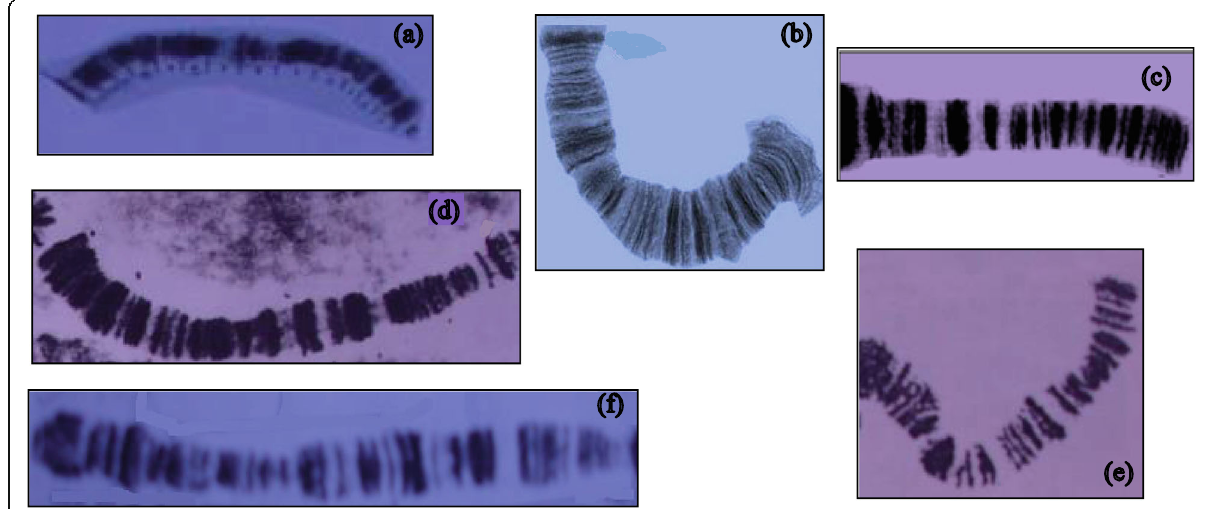
Fig. 6 Arm E of the polytene chromosomes of six species of Chironomus. a C. javanus. b C. dorsalis. c C. riparius . d C. matures. e C. maddeni. f C. duplex